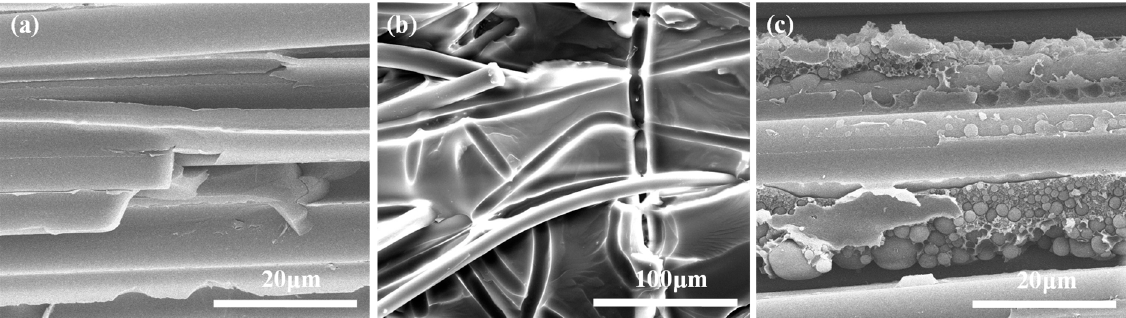
Figure 10. Comparison of the interlaminar failure morphologies among three G IIC samples after etching. ( a ) NT-Composite; ( b ) NWT-Composite; ( c ) DMT-Composite.